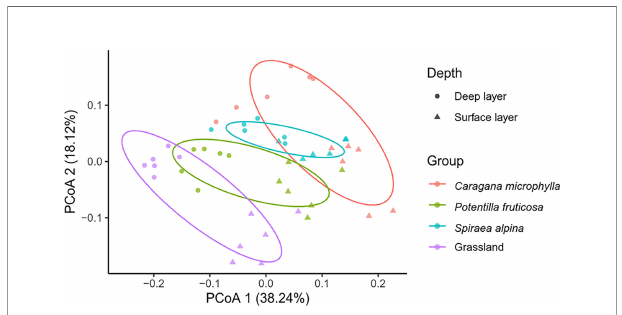
FIGURE 6 | Principal coordinate analysis (PCoA) of soil bacterial community in the shrub and grassland patches based on weighted